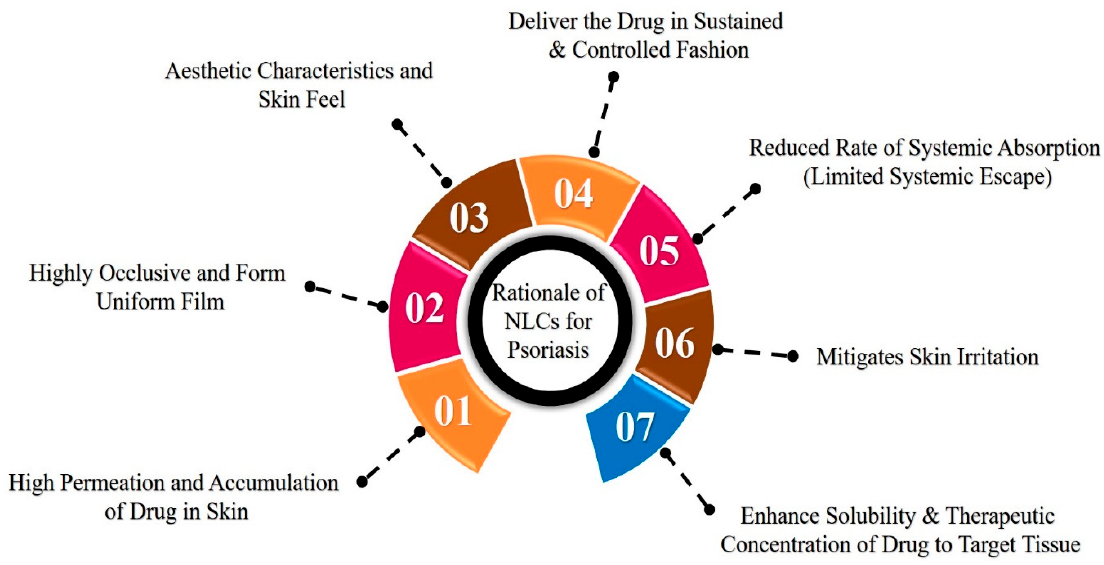
Figure 4. Advantages of nanostructured lipid carriers (NLCs) over other nanocarriers.